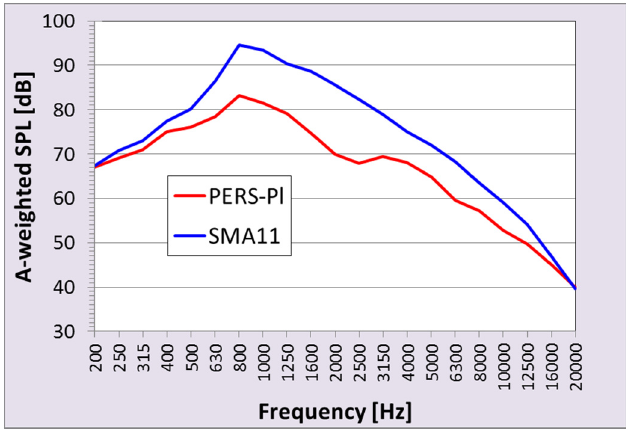
Figure 6. A-weighted spectra for passenger car tires measured by CPX method. Figure 6. A ‐ weighted spectra for passenger car tires measured by CPX method. Figure 6. A ‐ weighted spectra for passenger car tires measured by CPX method.